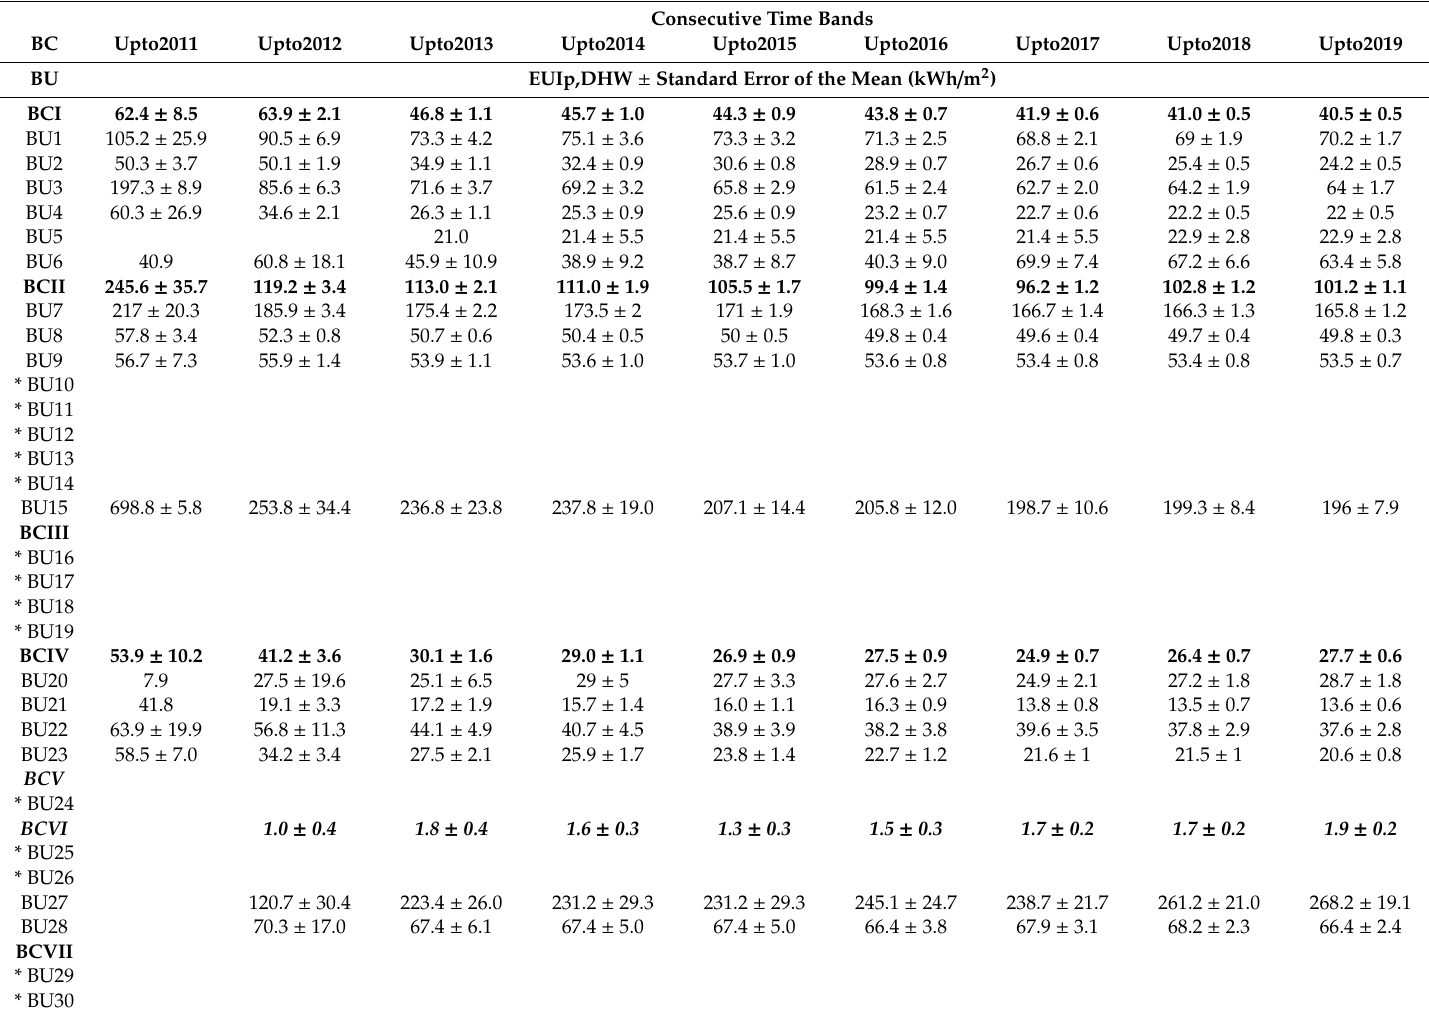
Table 5. Time evolution of calculated average primary energy use for DHW for the di ff erent building categories and building uses in the NR